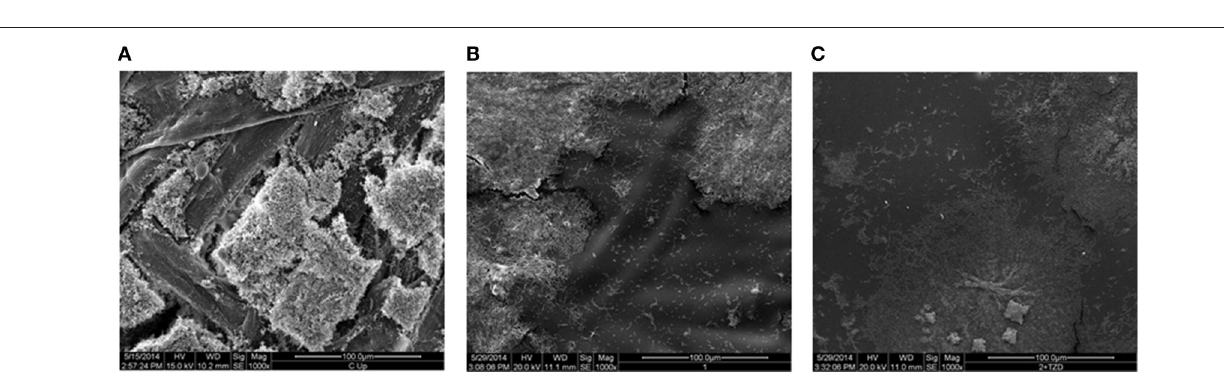
FIGURE 5 | Scanning electron micrographs of P. carotovorum biofilms grown on (A) corrugated cardboard surfaces without polymer, bare polymer covered corrugated cardboard (B), and polymer + TZD-6 covered corrugated cardboard (C). Cellulose fibers are clearly discernible on the bare corrugated cardboard images, as are robust biofilms. Images of coated surfaces show significantly less biofilm (white rods/clusters). This effect is magnified with the introduction of TZD-6 into the polymers (C)